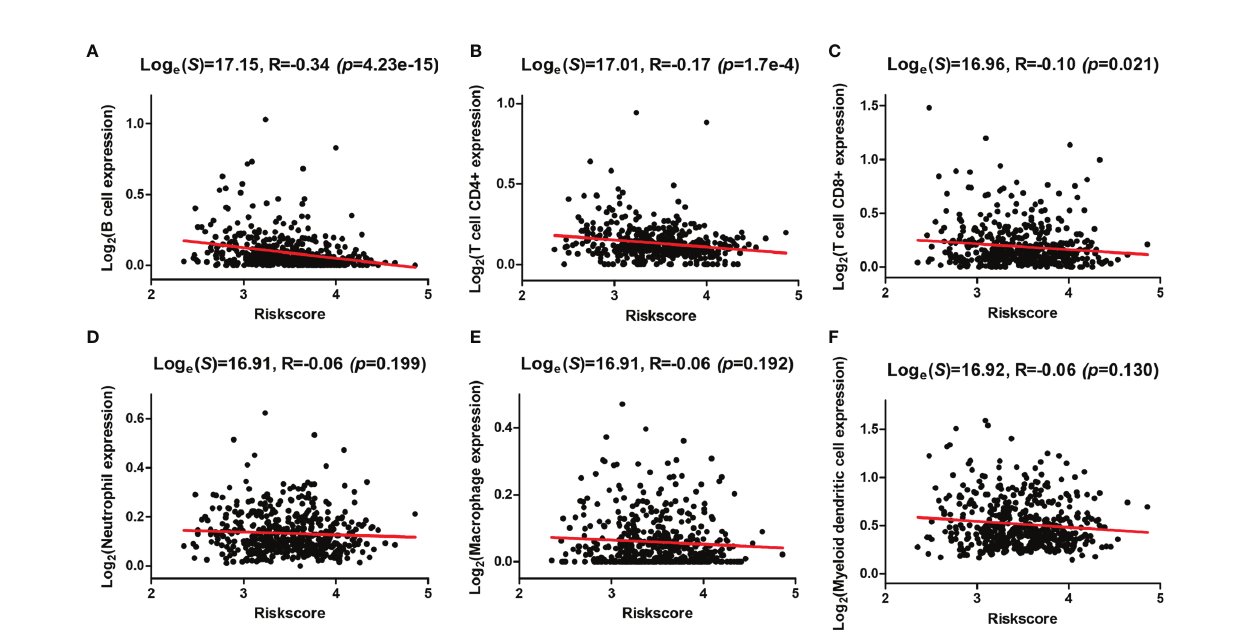
FIGURE 7 | Correlations between the risk model and in fi ltration abundances of six types of immune cells. (A – F) Correlations between the risk score and six types of tumor-in fi ltrating immune cells including B cell (A) , T-cell CD4+ (B) , T cell CD8+ (C) , neutrophil (D) , macrophage (E) , and myeloid dendritic cell (F) .